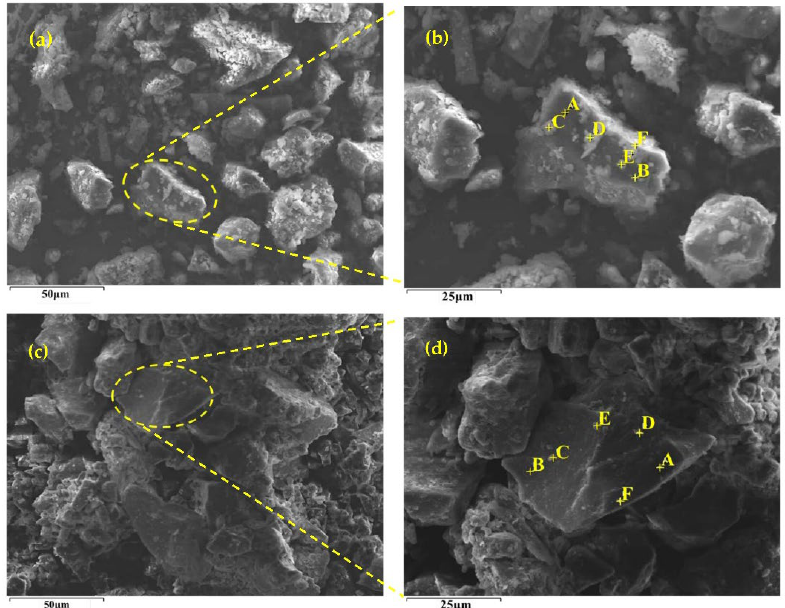
Figure 4. SEM images of raw coal magnified 1000 times ( a ); raw coal magnified 2000 times ( b ); coal samples were treated with SPP at 1000 times magnification ( c ); and coal samples were treated with SPP at 2000 times magnification ( d ). Letters A-F are the EDS point scanning positions respectively . Table 3. EDS point scanning spectral analysis of coal sample.